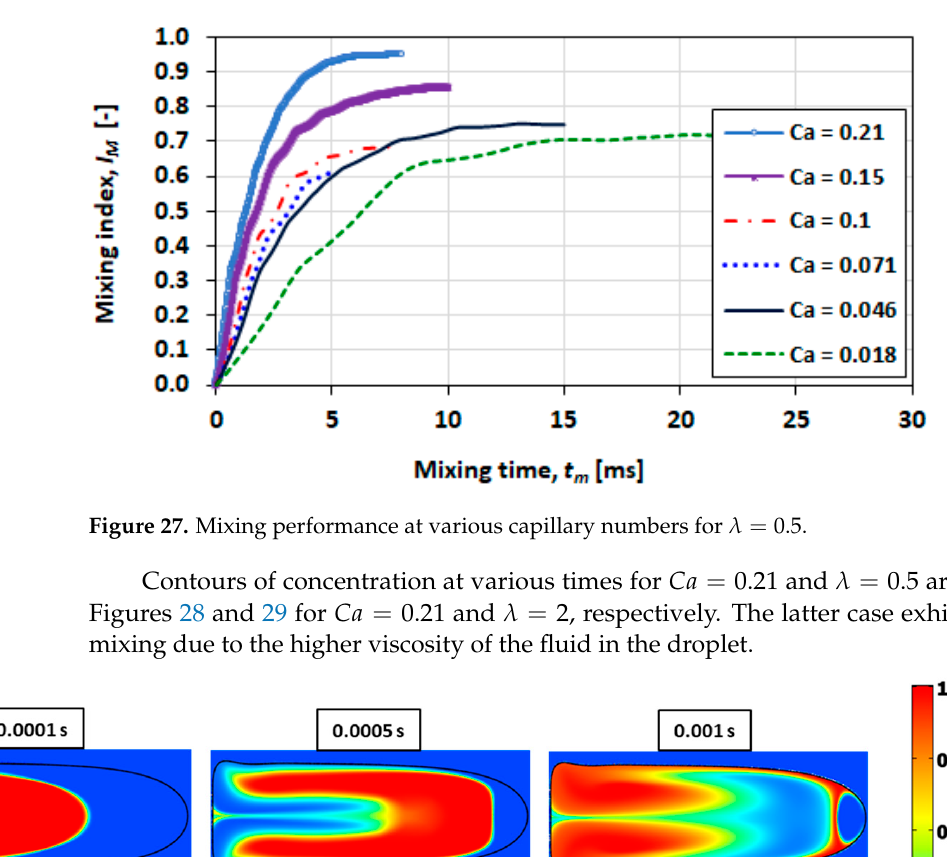
Figure 26. Mixing performance at various capillary numbers for 𝜆 = 0.1 .